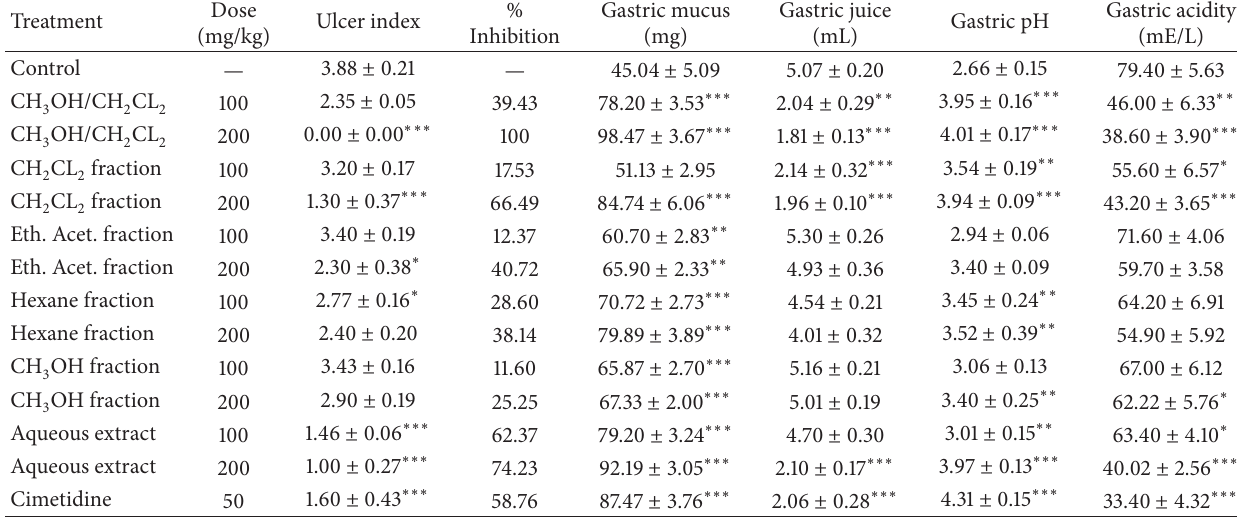
Table 2: Effects of E. speciosa extracts and fractions on gastric acid secretion and ulceration in pylorus ligated rats. Treatment Control